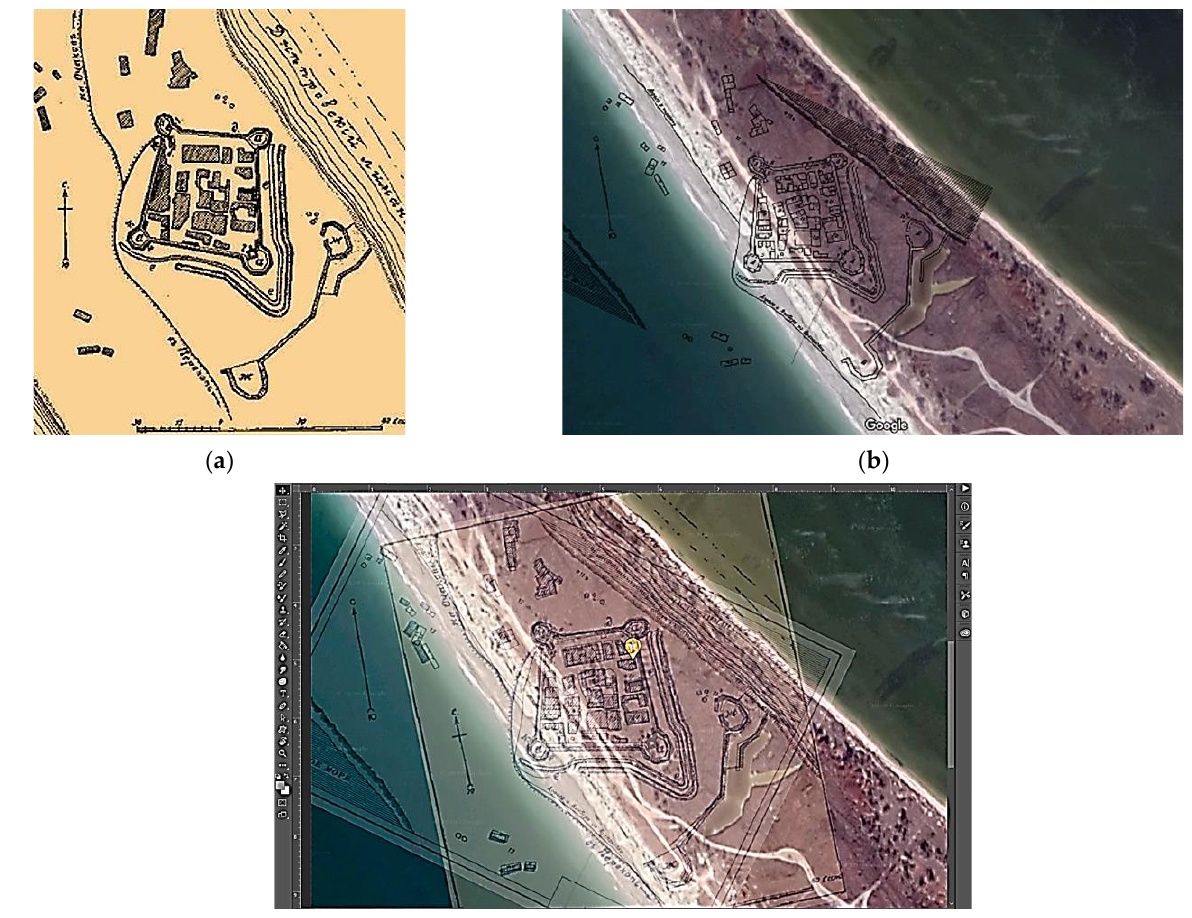
Figure 4. Analysis ( a ), overlay ( b ), and processing ( c ) of